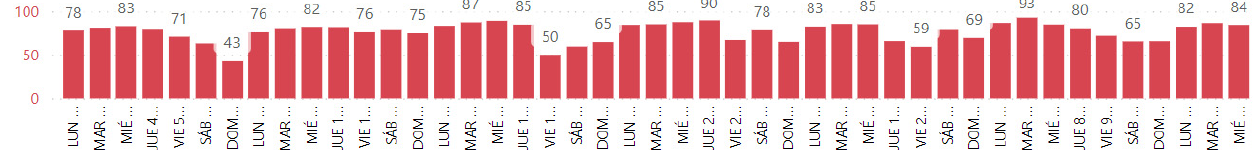
Figure 7. Evolution of daily mobility using public transport in Cartagena in March and April 2021 (in blue) compared to 2019 (in red). Data source: Ministry of Transport of Spain and Cartagena City Council. Figure 8. Percentage of daily mobility using public transport in Cartagena in March and April 2021 compared to the same days in 2019. Data source: Ministry of Transport of Spain and Cartagena City Council.